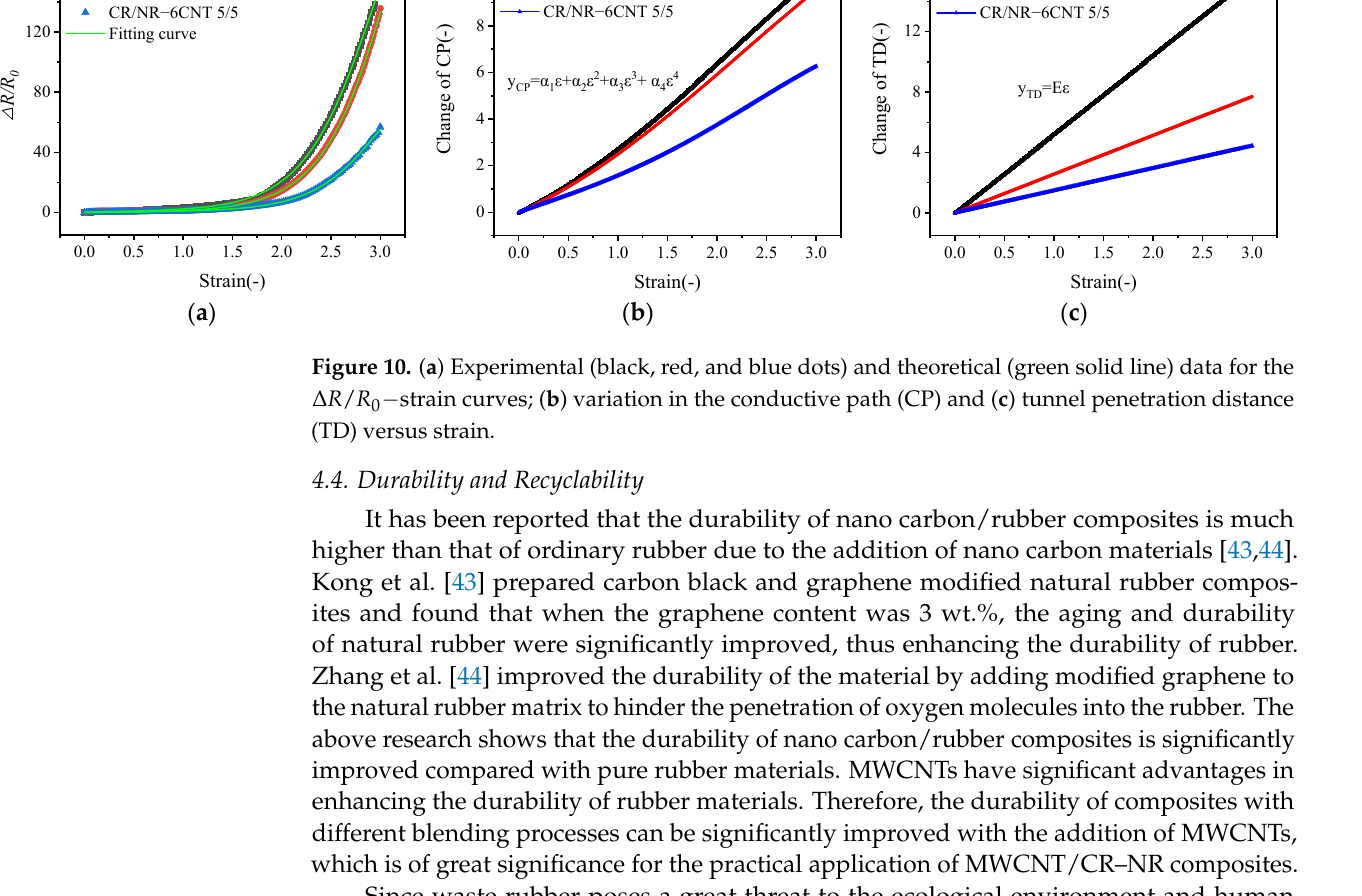
Table 3. The fitting parameters of Equation (17).